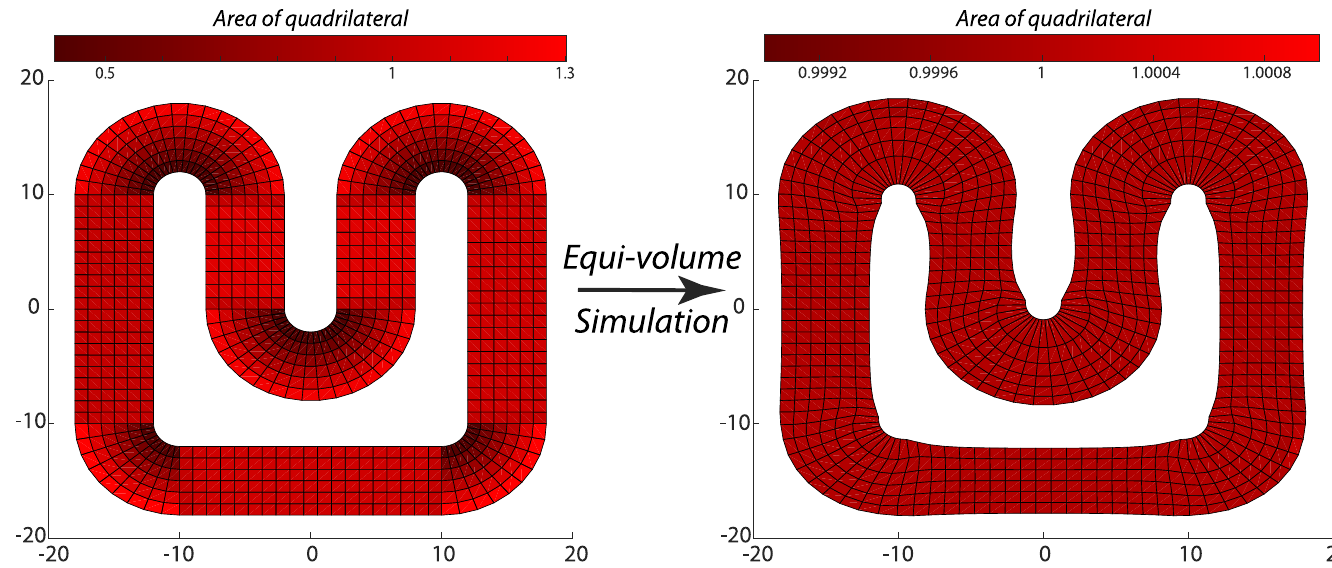
Fig 2. From an initially equidistant mesh, on the left, we let the points on the mesh rearrange itself in an equivolume manner. The area of a single quadrilateral is indicated by its colour. The resulting mesh, on the right, is rearranged such that all quadrilaterals had unit area ( ± 10 − 3 ). Note that as a result, the layers start varying in thickness in the inner and outer